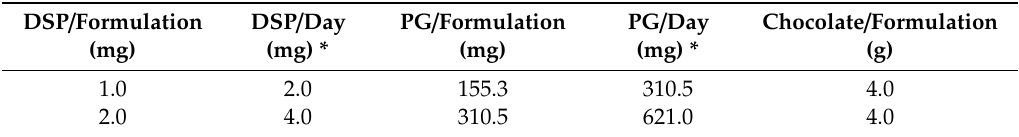
Table 1. Quantities of excipients’ and dexamethasone sodium phosphate (DSP) per formulation or per daily